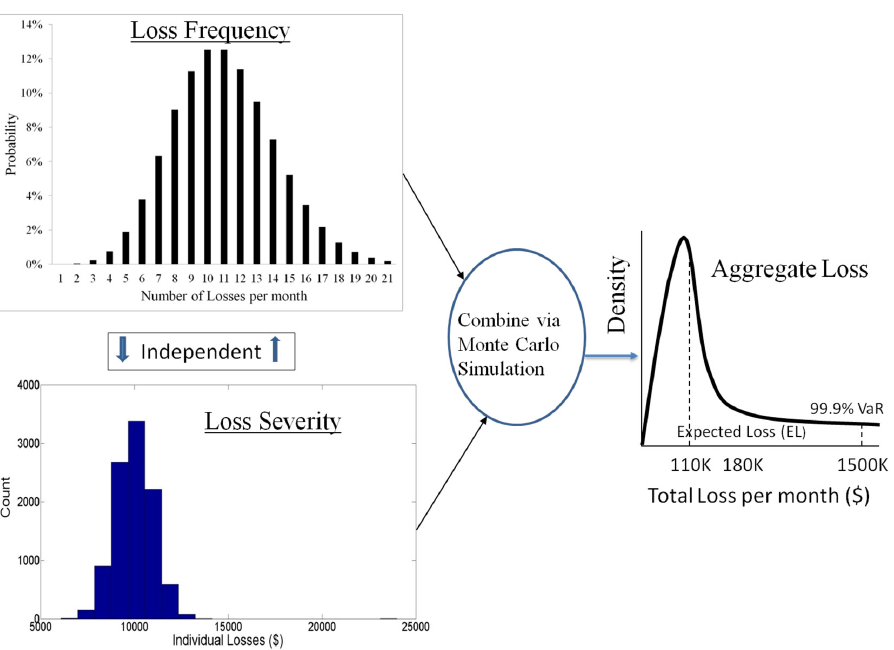
Figure 1. Here we show a visual depiction of the Value ‐ at ‐ Risk (VaR) estimation process using the classical method. By default, the loss frequency and loss severity are independently estimated and the aggregate loss distribution is generated via a Monte Carlo simulation (MCS) to estimate VaR.